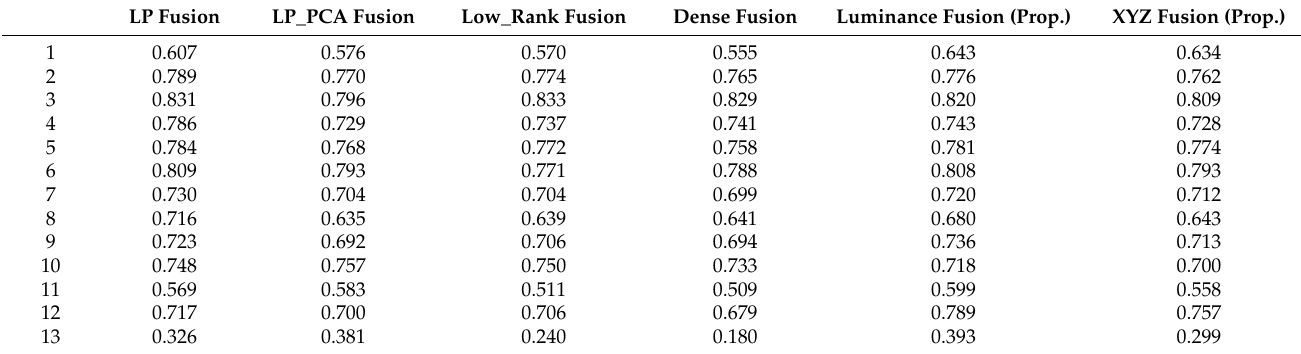
Table 7. Comparison of the CPBD sharpness